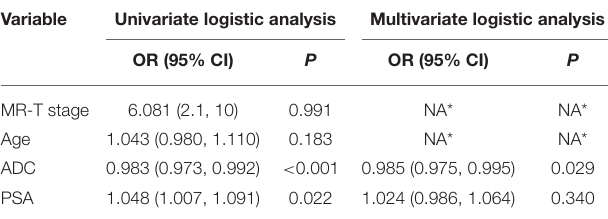
TABLE 2 | Logistic regression analyses for discriminating between clinically significant and clinically insignificant prostate cancer.